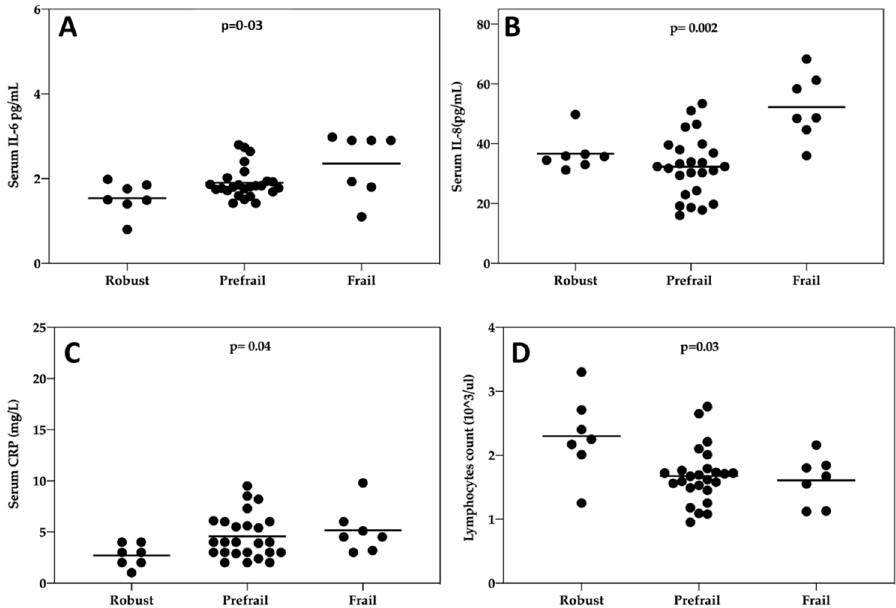
Figure 2. Evaluation of relationship between frailty syndrome and inflammatory markers at baseline. Frailty was measured according to the 5 criteria proposed by Fried et al. (see Methods). ( A ) IL-6 (pg/mL), ( B ) IL-8, (pg/mL) ( C ) CRP (mg/L), ( D ) lymphocytes s(1 × 10*3/µL) were measured in the blood and were plotted against the categories of frailty.